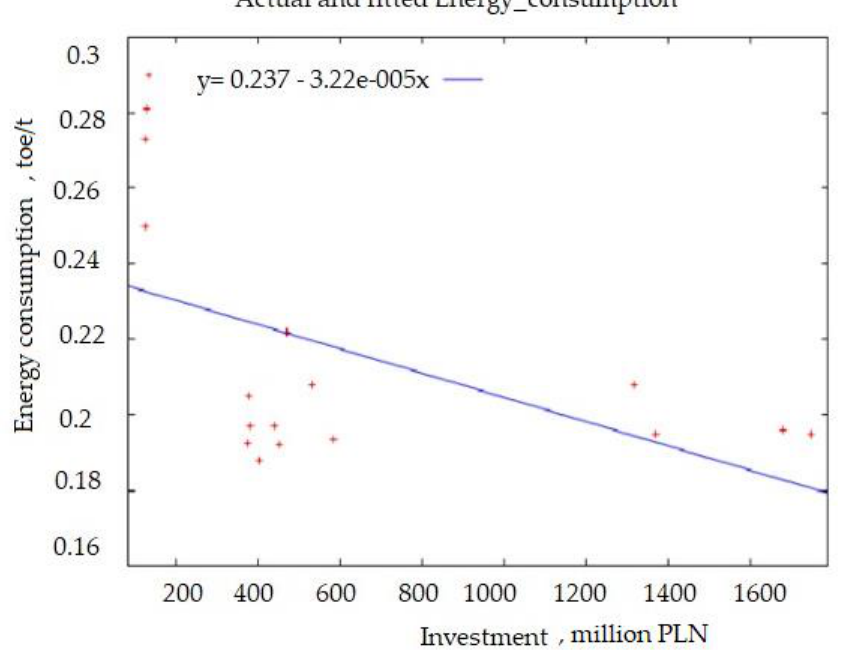
Figure 8. Correlation between energy consumption and investment for the period 2003–2019 taking into account the 3 years of inertia of investment effects.